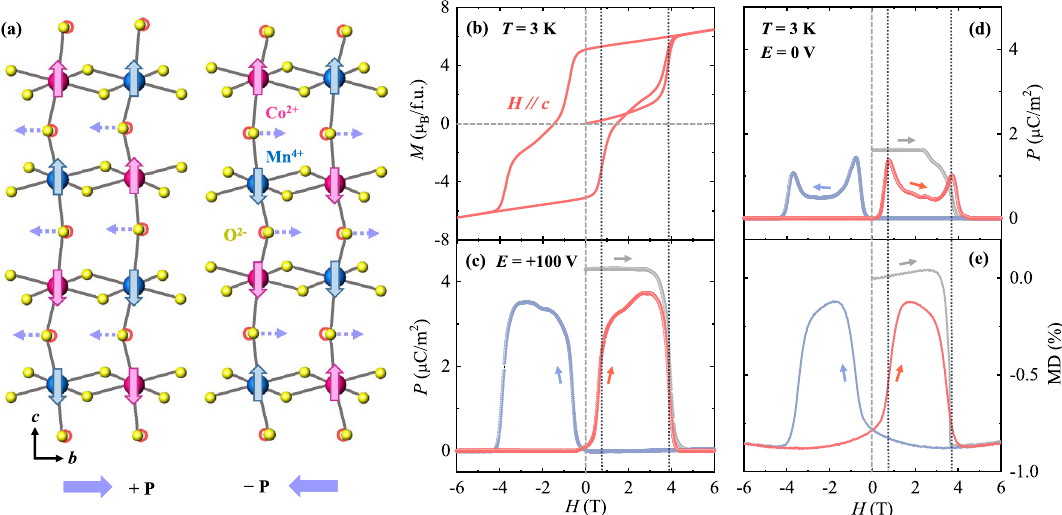
Figure 2. Origin of ferroelectricity in frustrated antiferromagnetic domains and magnetoelectrically hysteretic behavior. ( a ) Two types of frustrated antiferromagnetic domains. The purple dotted arrows denote the shifts in O 2− ions due to the exchange striction between parallel and antiparallel neighboring spins. ( b ) Isothermal magnetization of the YCMO crystal measured at T = 3 K in an H range of ± 6 T along the c axis. ( c ) and ( d ) Isothermal polarization perpendicular to the c axis at T = 3 K and H along the c axis, measured with E = 100 and 0 V, respectively. ( e ) Magnetodielectric (MD) effect defined as MD (%) = ε the c axis for H up to ± 6 T along the c